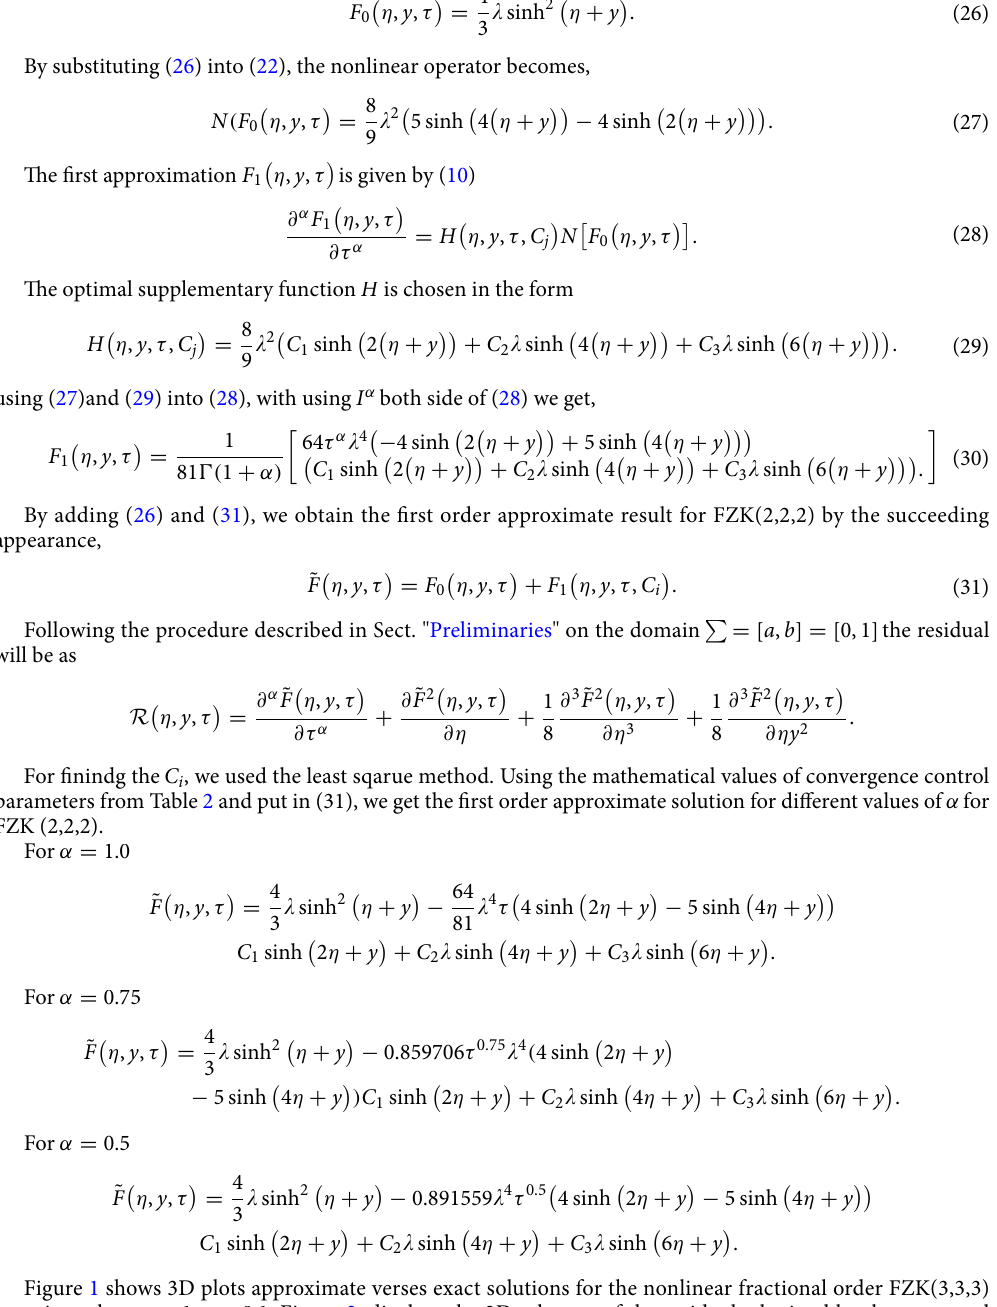
By substituting (26) into (22), the nonlinear operator becomes,